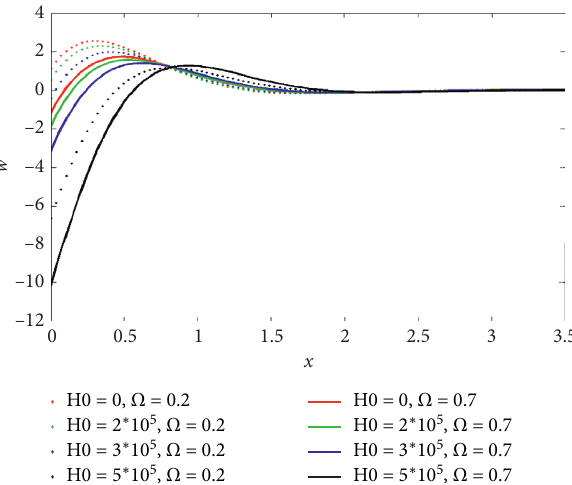
+ σ x with laser pulse “ t ” and zz zz concerning